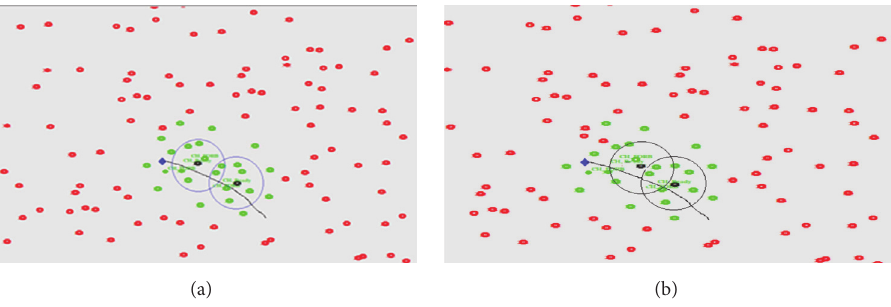
Figure 10: (a) Simulation with ATHVC. (b) Simulation with